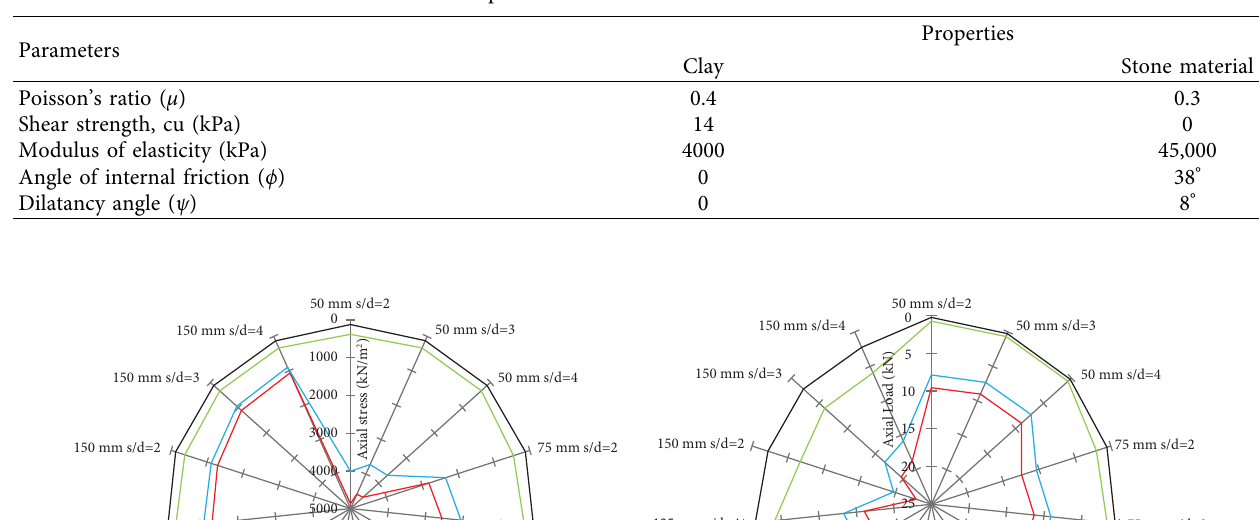
Table 3: Properties of the materials used for PLAXIS 3D.